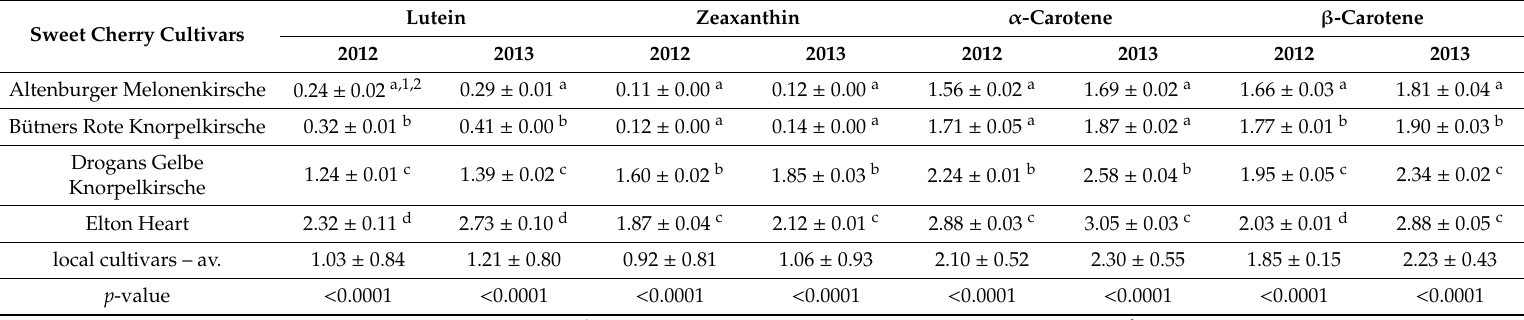
Table 6. The content of carotenoids (in mg 100 g -1 FW) in sweet cherry fruit of local cultivars harvested in 2012 and 2013.